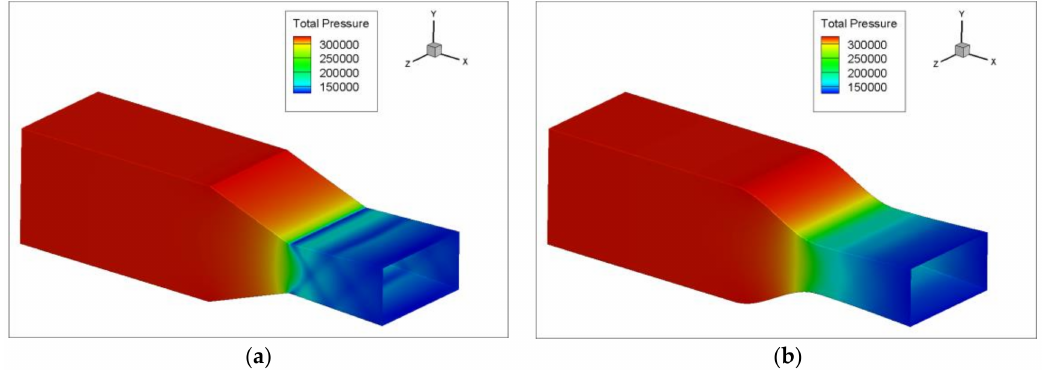
Figure 9. Total pressure on nozzle walls; ( a ) existing design and ( b ) improved design.